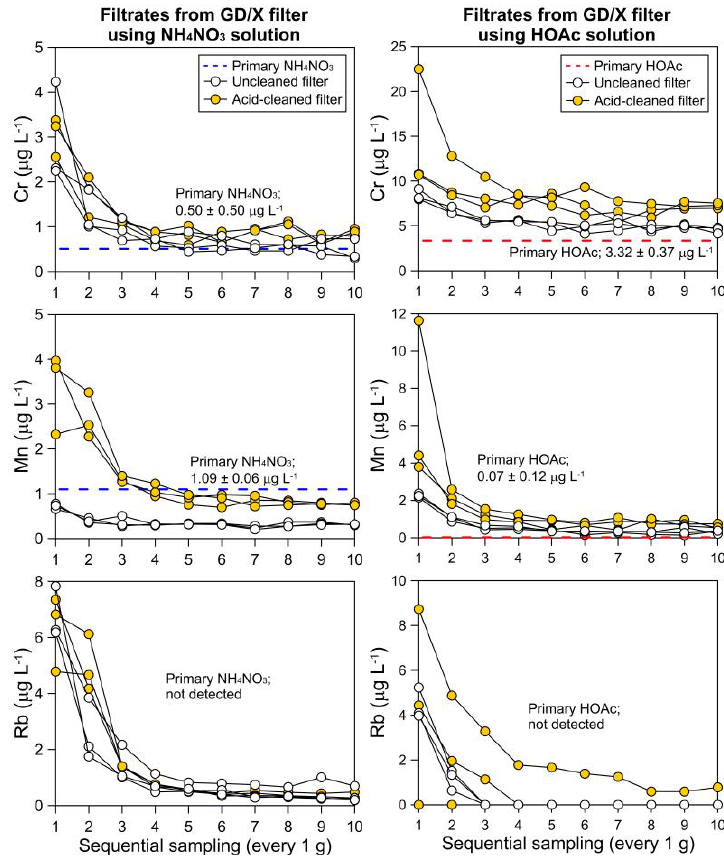
Figure 3. Variation in Cr, Mn, and Rb concentrations in filtrate passed through uncleaned and acid- cleaned filters. Samples were sequentially collected from 1 to 10